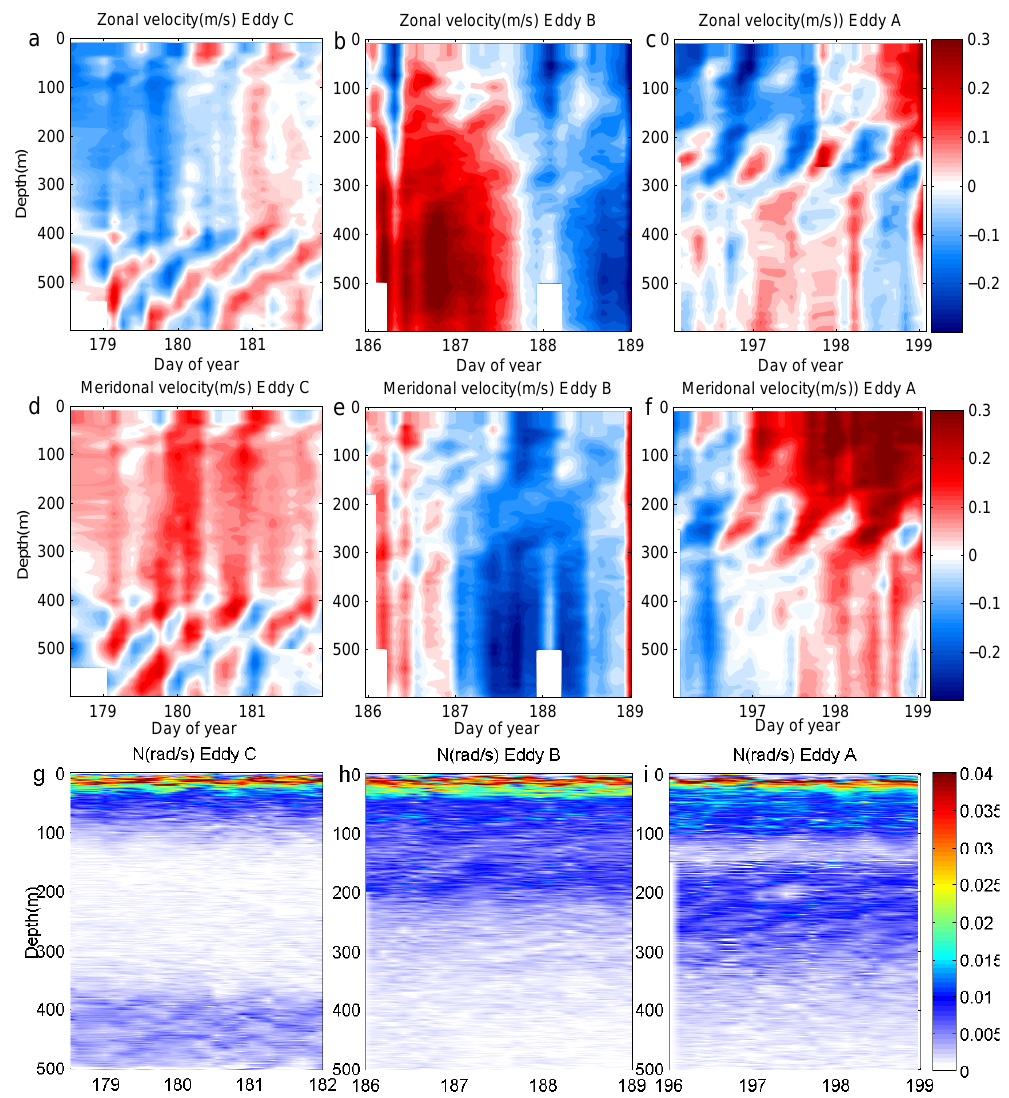
Fig. 3. Time depth plots of: (a) , (b) , (c) zonal velocity, (d) , (e) , (f) meridional velocity, (g) , (h) , (i) stratification profiles N(z) for each LD Figure 3: Time depth plots of: (a), (b), (c) zonal velocity, (d) (e) (f) meridional velocity, (g) (h) (i) strati(cid:28)cation pro(cid:28)les N ( z ) for each LD station